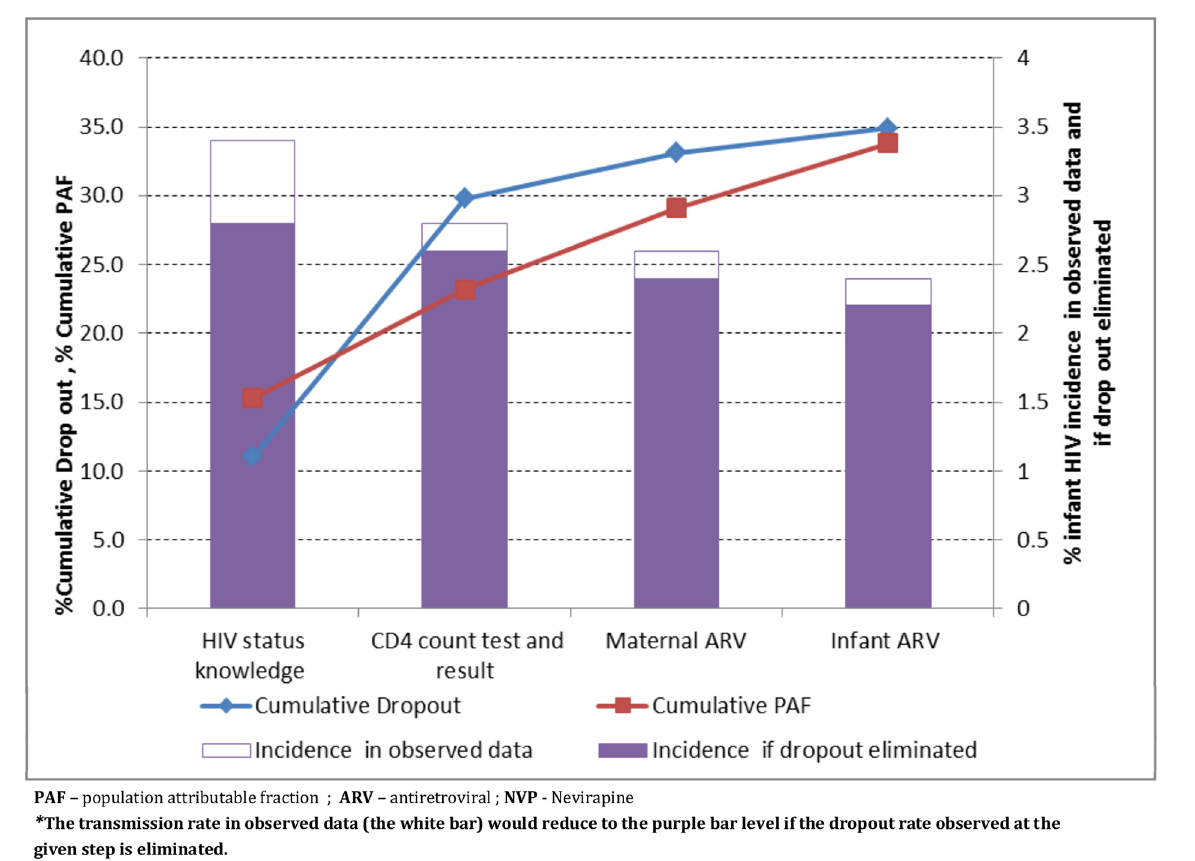
Fig 2. The increase in cumulative PAF as cumulative dropout rate increases (red and blue lines), and reduction in infant HIV incidence if dropout is eliminated (purple bar *